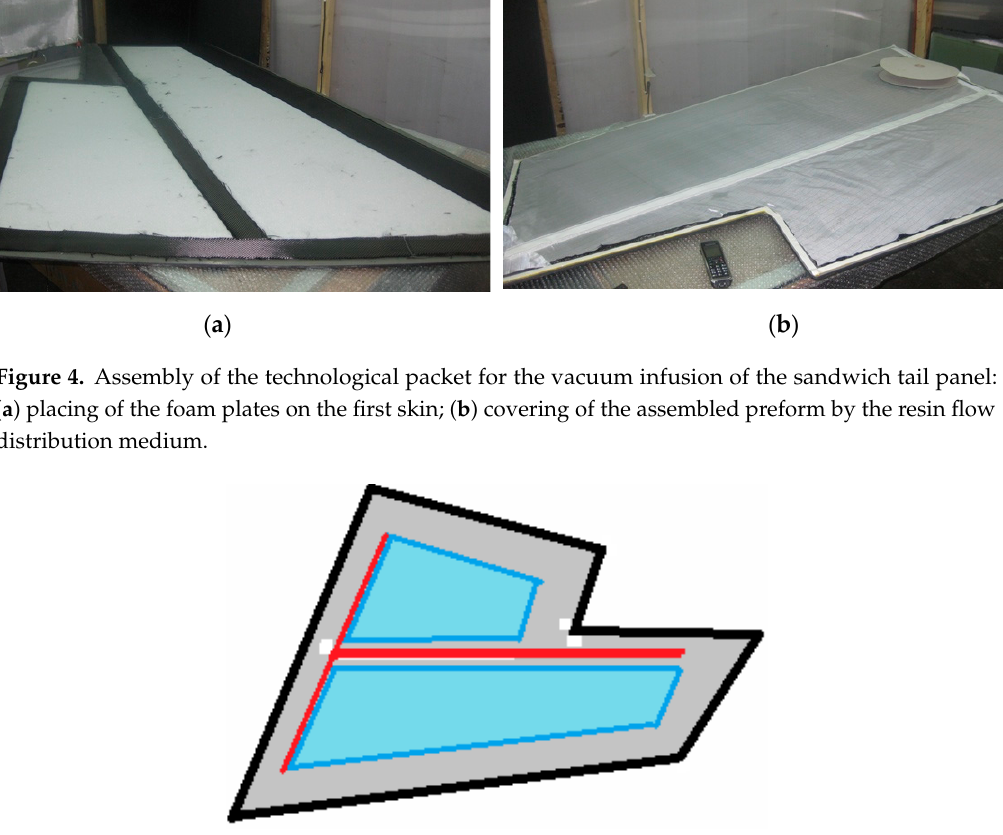
Figure 5. The resin feed channel (red line) for the vacuum infusion of the sandwich tail panel.